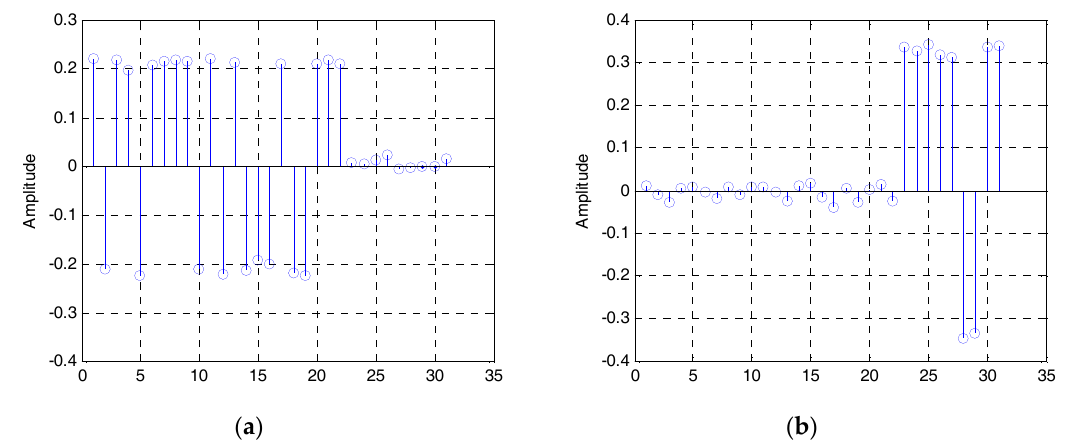
Figure 4. The estimated eigenvectors: ( a ) The eigenvector corresponding to the largest eigenvalue; ( b ) the eigenvector corresponding to the second largest eigenvalue. Sensors 2018 , 18 , x FOR PEER REVIEW